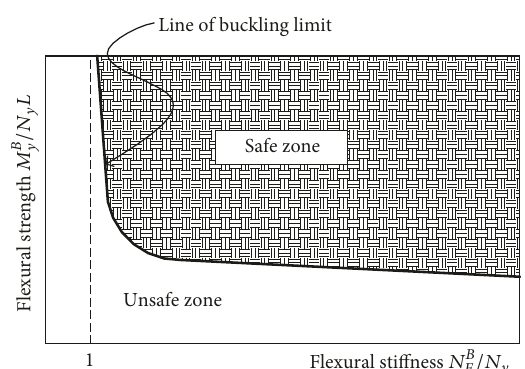
Figure 2: Interaction diagram for design of BRB [21].